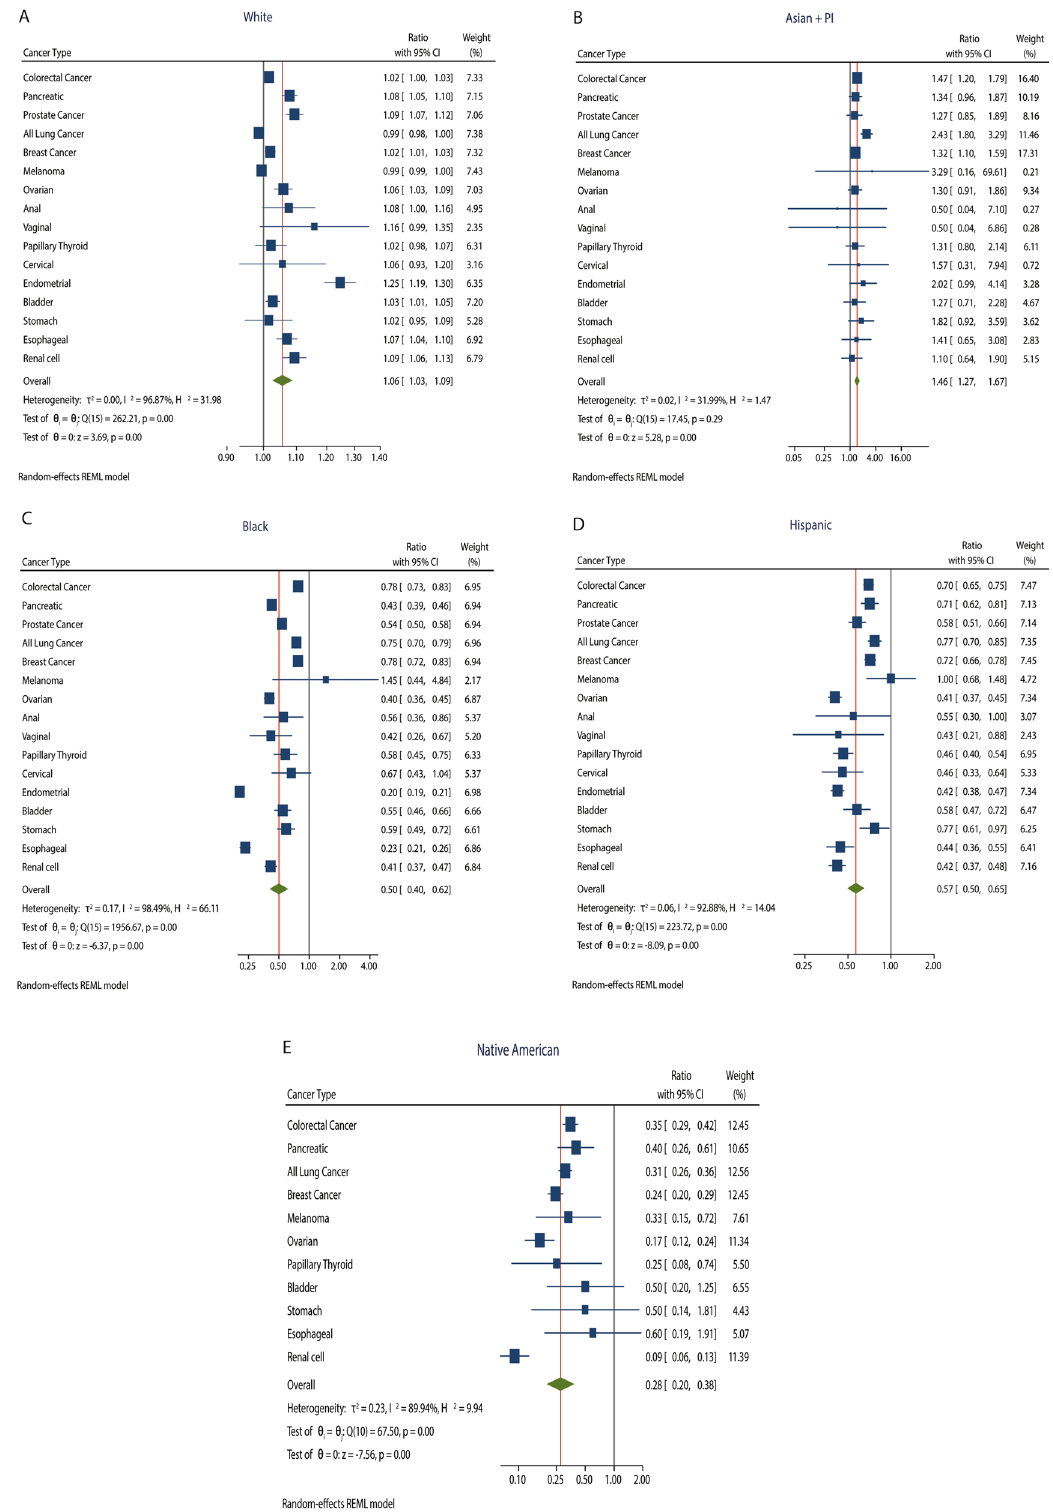
Fig. 1 Representation of racial/ethnic samples in GENIE relative to US cancer population. Squares represent the ratio of observed to expected number of samples in GENIE; whiskers show 95% CI. Ratios to the left of the black line (1.00) indicate under-representation. Overall ratios for a given racial/ethnic group are indicated by green diamonds and red lines. A White. B Asian + PI. C Black. D Hispanic. E Native